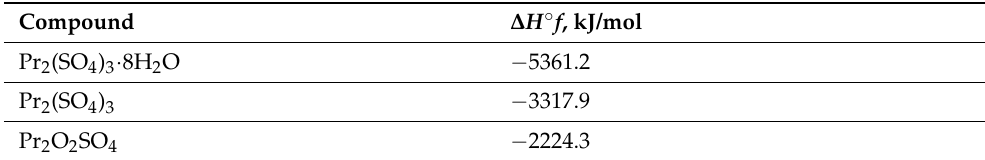
Table 4. Standard enthalpies of praseodymium sulfate formation.